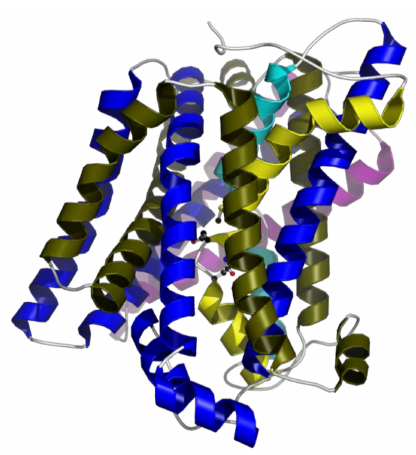
Figure 1. Structural model of MntH2 from E. faecalis . The model has been prepared with I-TASSER and is mostly based on the structure of E. coleocola MntH (PDB ID: 5M87) [20]. The yellow and blue